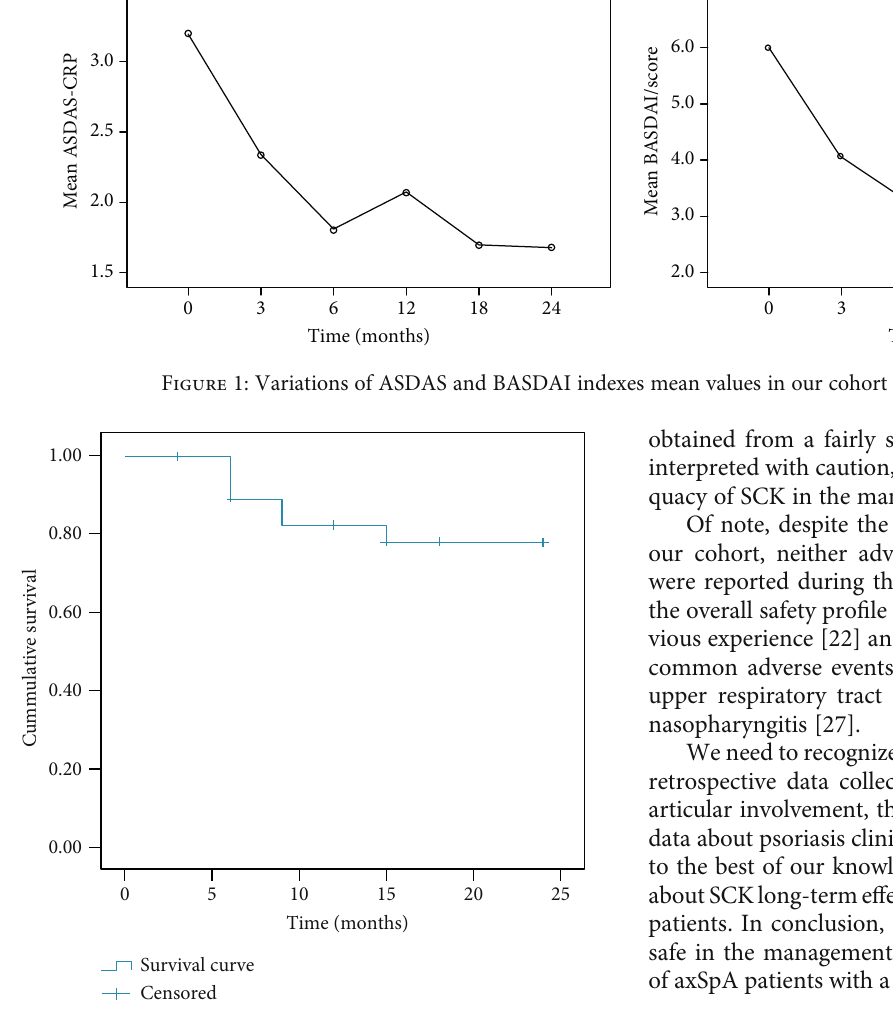
Figure 2: The survival Kaplan-Meier curve of our axSpA cohort treated with